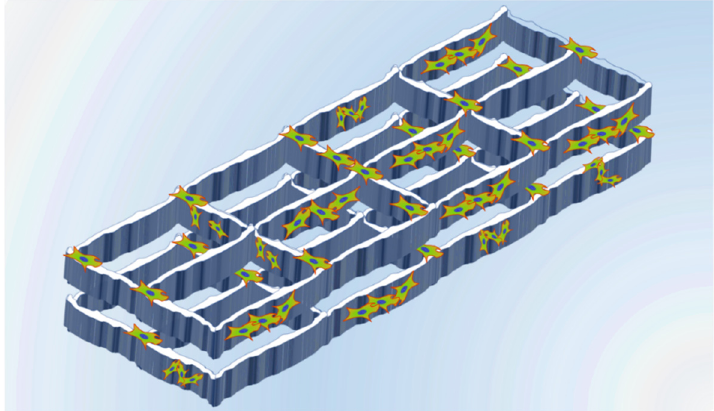
Figure 18. Porous sol-gel silica coatings on cell cultures generated by the biosil method, adapted from the information provided by M. Muraca et al. [90].